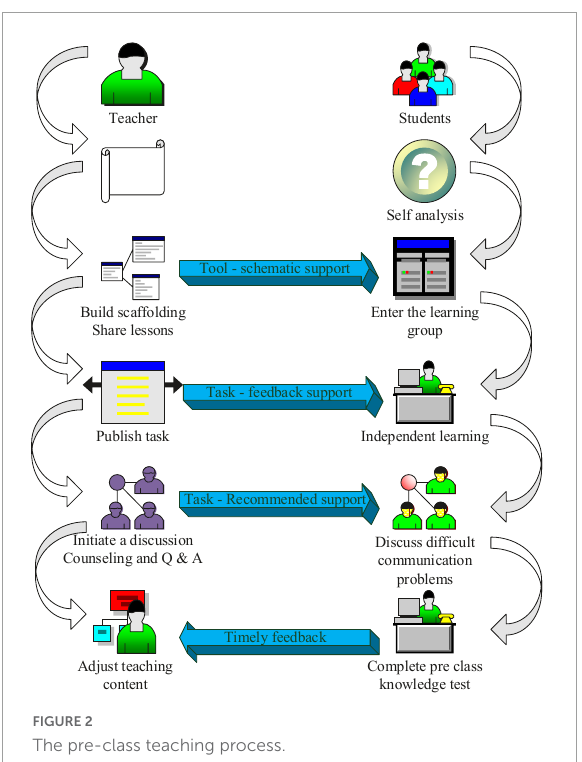
FIGURE2 The pre-class teaching